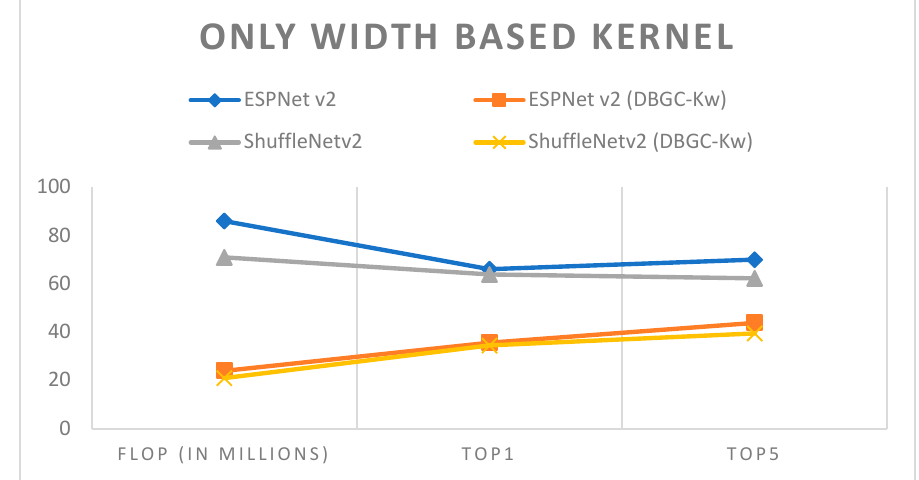
Figure 15. Only width-based kernel.